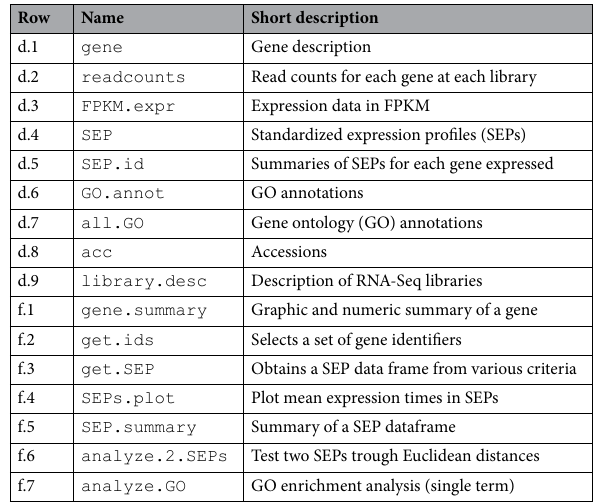
Table 4. Main data frames (rows “d.”) and functions (rows “f.”) in Salsa.